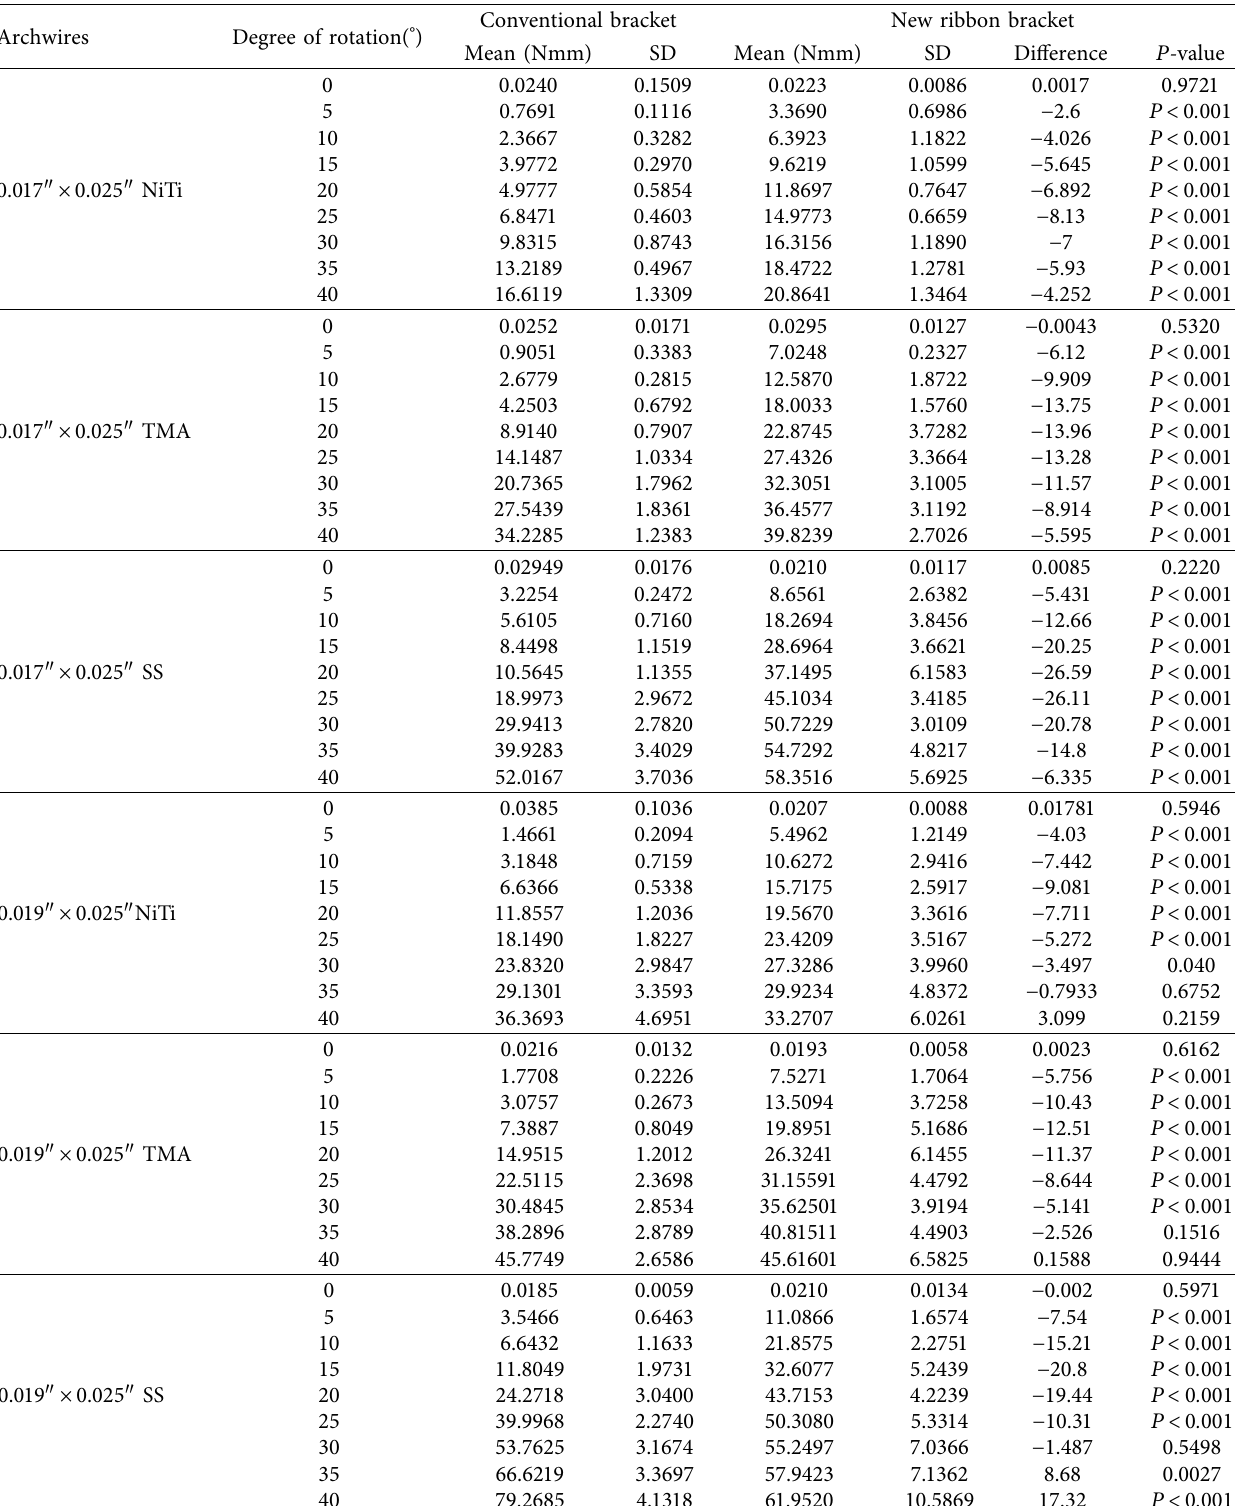
Table 2: Mean, standard deviation (SD), mean difference, and t -test result of the moment (Nmm) at every 5 degrees for different ex- perimental configurations ( n �